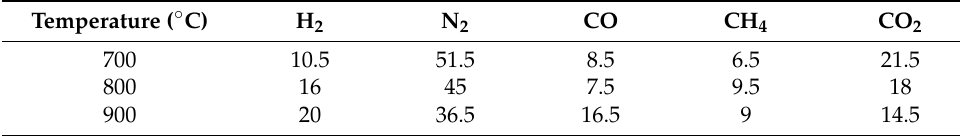
Table 3. Gas composition (mol.%) at 500